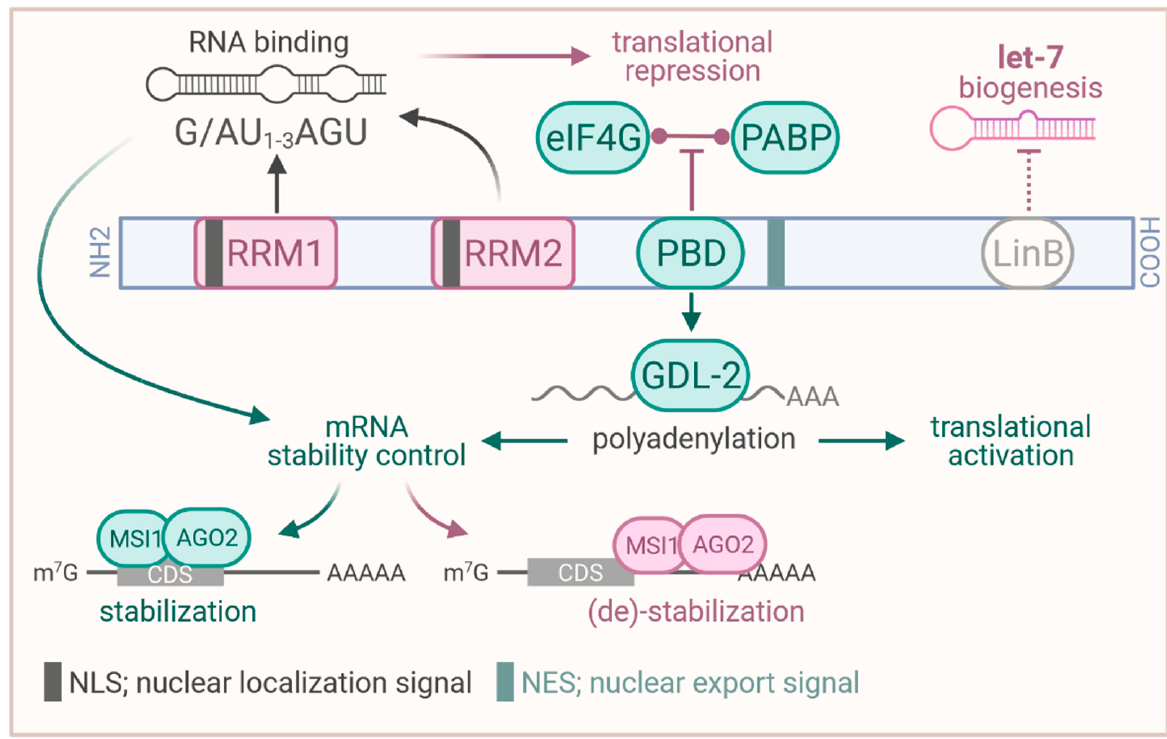
Figure 1. Structure of the MSI1 protein and proposed functions. RRM, RNA recognition motif; PBD; PABP binding domain (binding site to PABP and GLD–2); PABP, poly(A) binding protein; LinB, binding site to LIN28B; CDS, coding sequence. Created with www.BioRender.com (accessed on 29 April